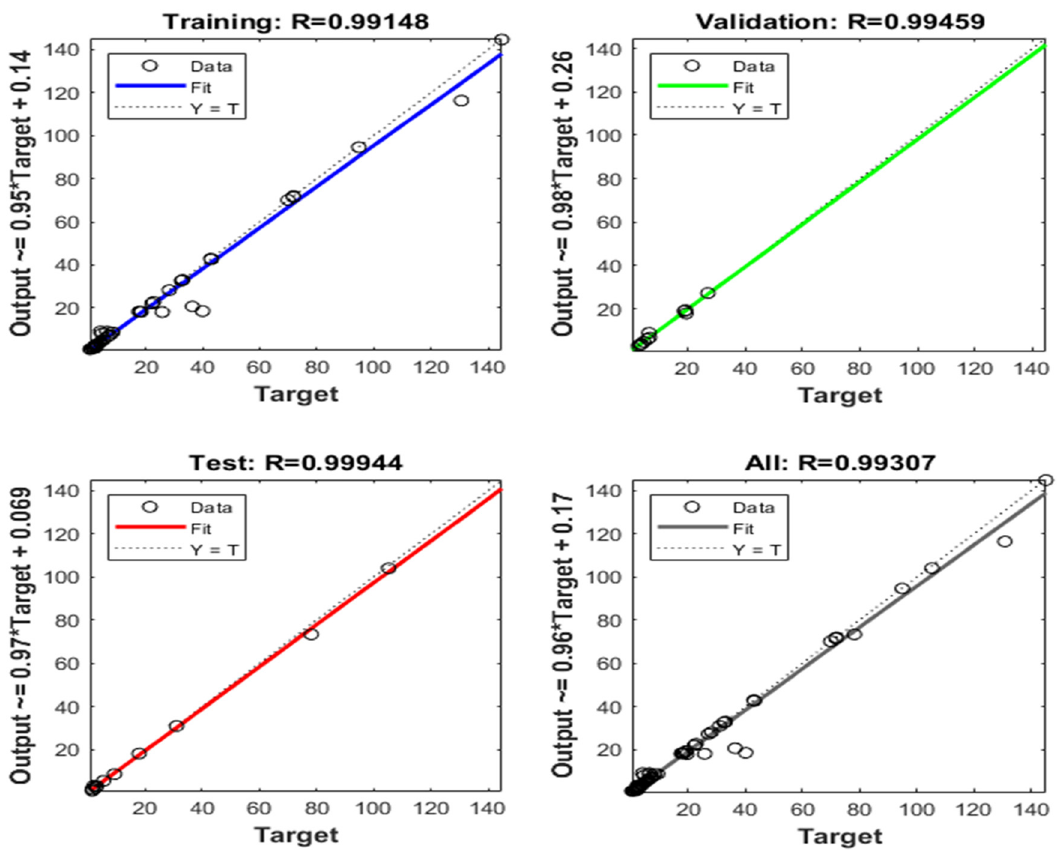
Figure 5: Comparative graph of actual and ANN projected values, using linear regression